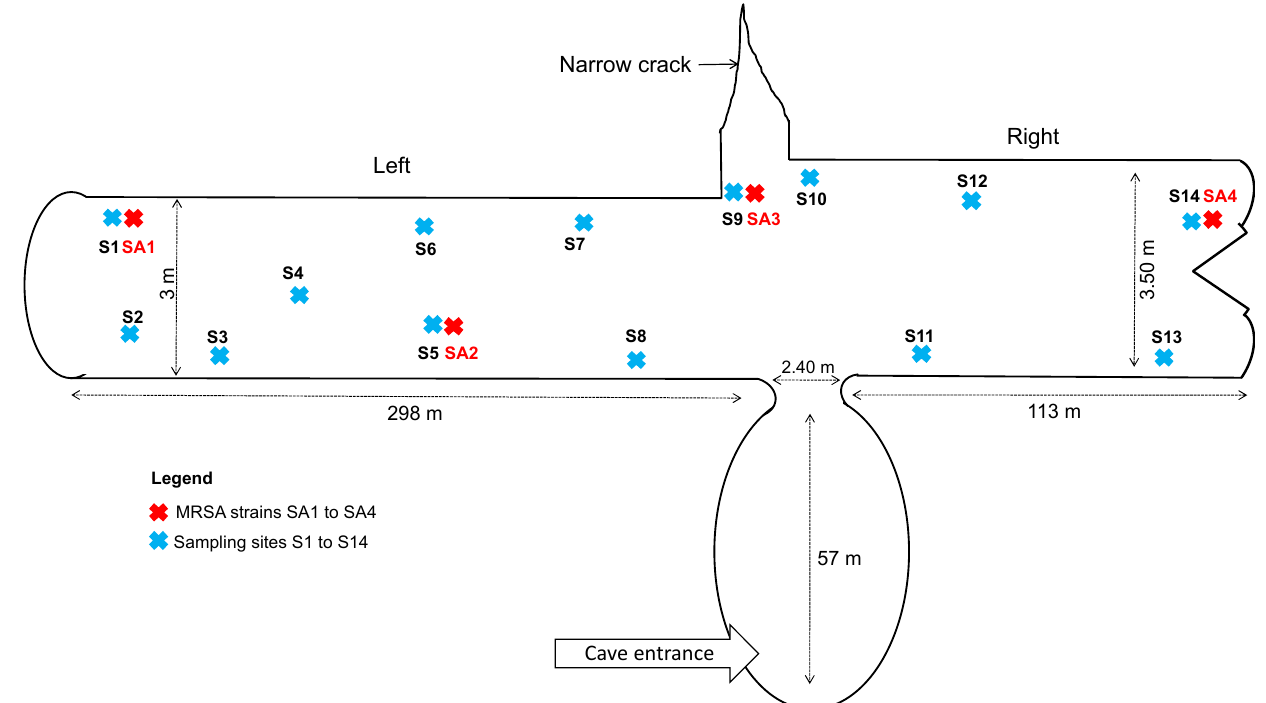
Figure 1. Schematic representation of the Aokas’s cave. Sx, site of sampling (x, number); SAx, site of S. aureus isolation (x, number).